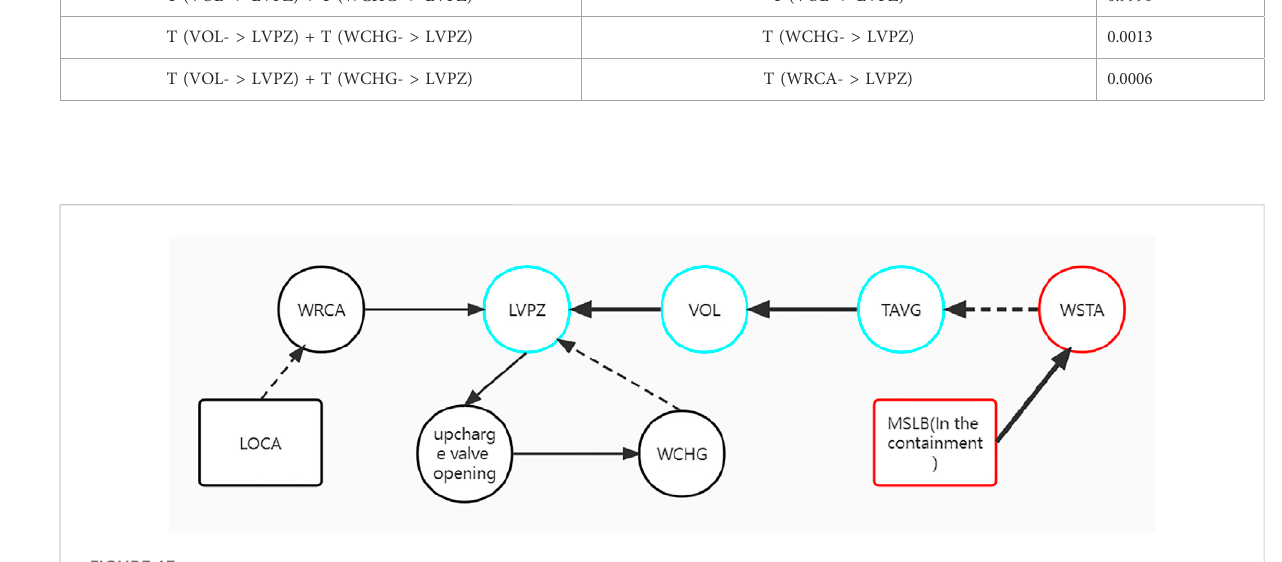
FIGURE 13 FR-SDG model of the regulator water level for MSLB failure.